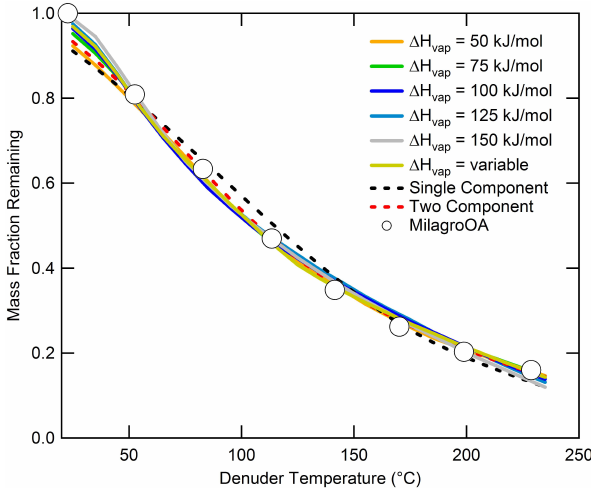
Fig. 1. Calculated (lines) and observed (circles) mass thermograms for the campaign average organic aerosol from Mexico City. Results are shown for each of the different 1H vap cases considered. The dashed lines in are the model results assuming the OA is comprised of only one (black) or two (red)